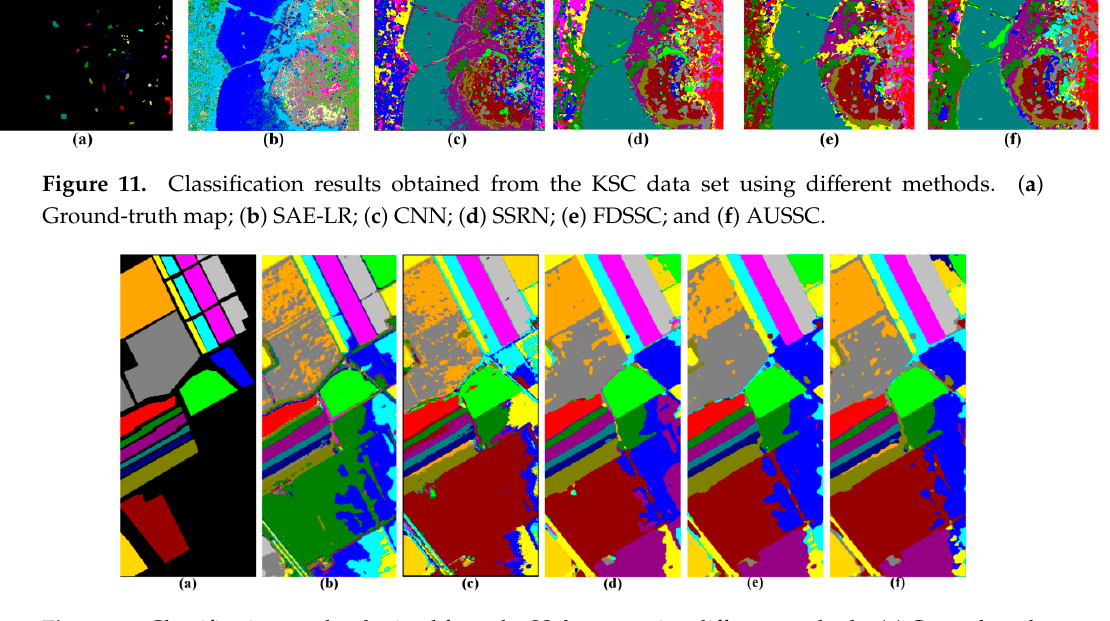
Figure 12. Classification results obtained from the SS data set using different methods. ( a ) Ground-truth map; ( b ) SAE-LR; ( c ) CNN; ( d ) SSRN; ( e ) FDSSC; and ( f ) AUSSC.